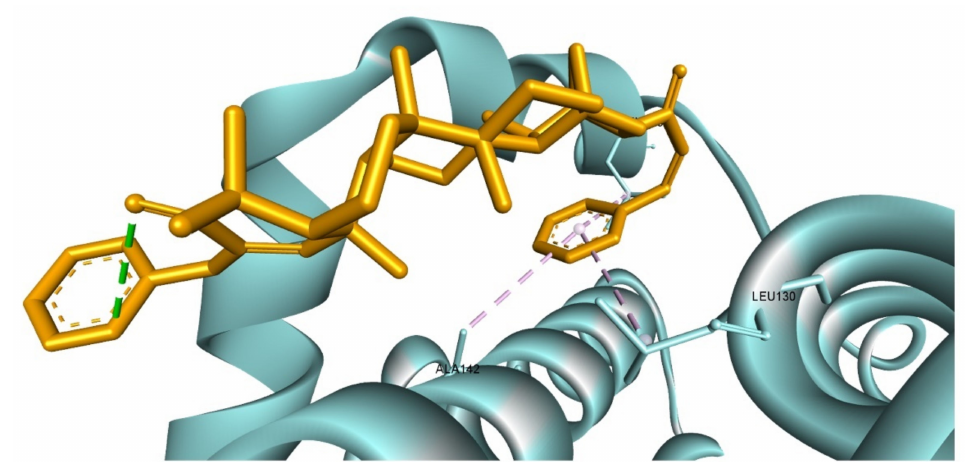
Figure 14. Structure of Bcl-XL (2YXJ) in complex with compound 6 (orange); HB interactions are depicted as green dotted lines and hydrophobic interactions as purple dotted lines; interacting amino acids are shown as light blue